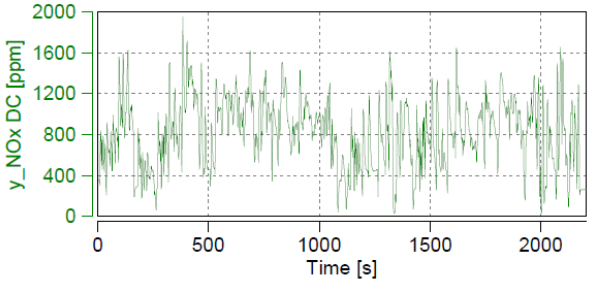
Fig. 9. Nitrogen oxides concentration during the test